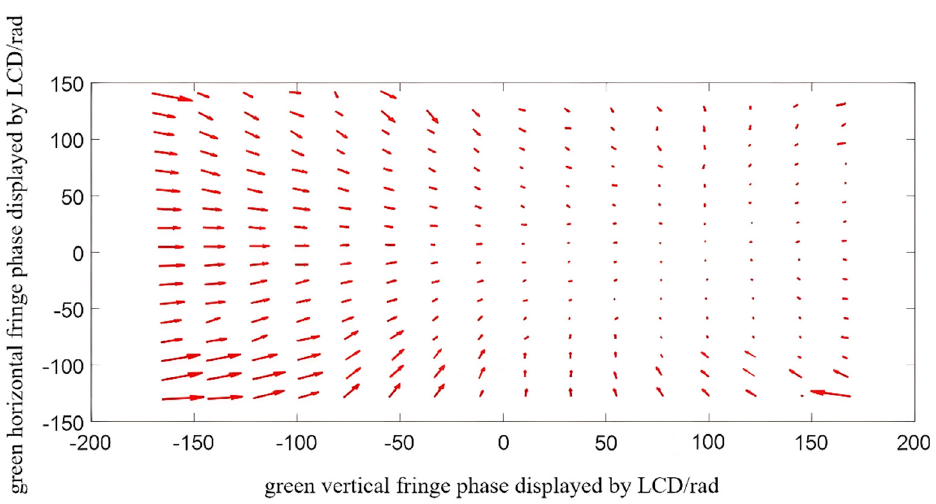
Figure 10. Schematic diagram of horizontal chromatic aberration of three − color channels.